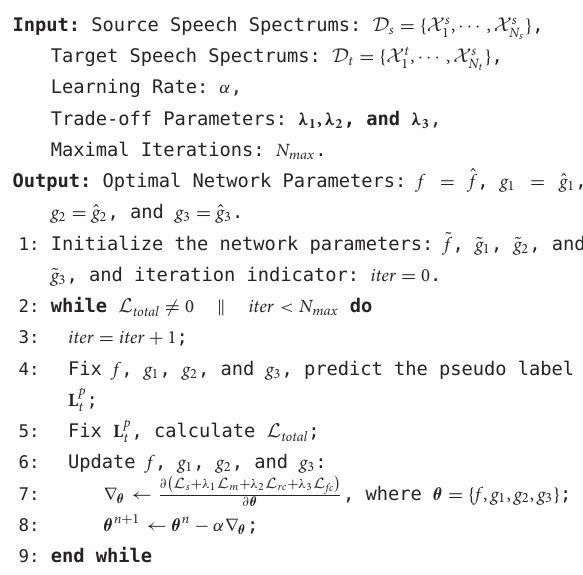
Algorithm 1. The detailed procedures for updating optimization problem of PDAN in Equation (5).